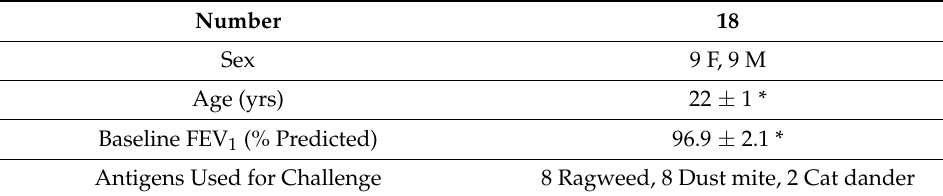
Table A1. SBP-Ag subjects’ characteristics.